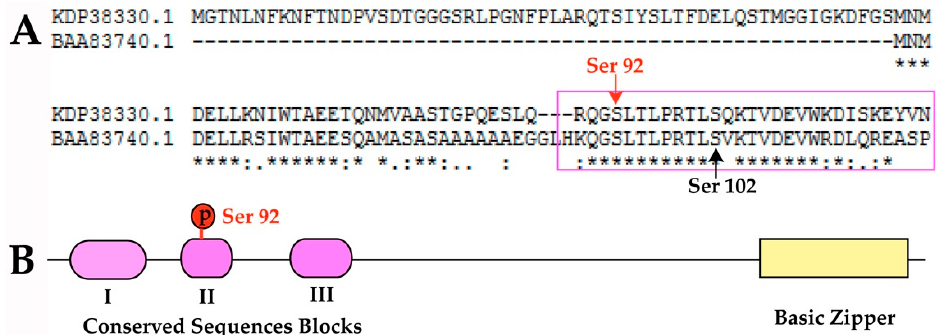
Figure 9. Sequence alignment and predicted structural composition of TRAB1 in J. curcas . ( A ) JcTRAB1 (KDP38330.1) sequence alignment with OsTRAB1 (BAA83740.1). The red line with arrow indicated the phosphorylation site of TRAB1 in J. curcas while black line with arrow indicated the phosphorylation site Ser 102 in O. sativa . The pink rectangle showed the conserved region II of TRAB1. ( B ) Predicted functional domain distribution of JcTRAB1.